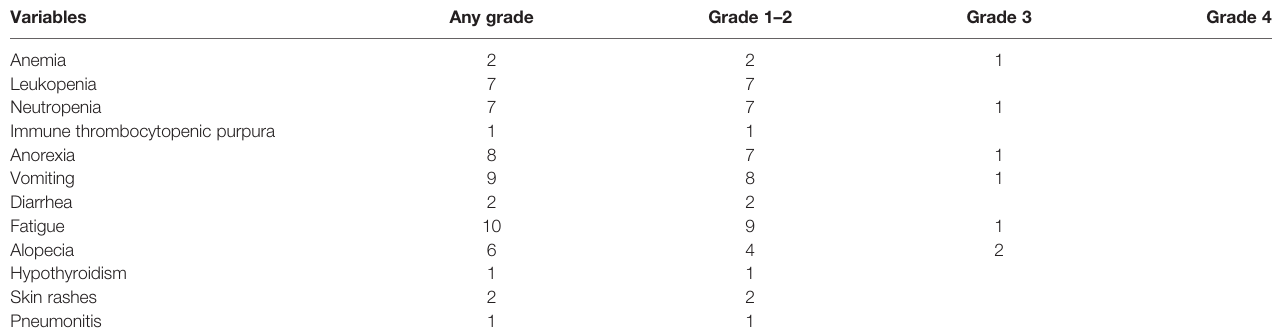
TABLE 2 | Treatment-related adverse